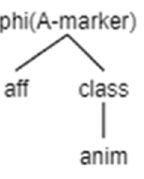
Figure 30. Geometry of the Phi label.